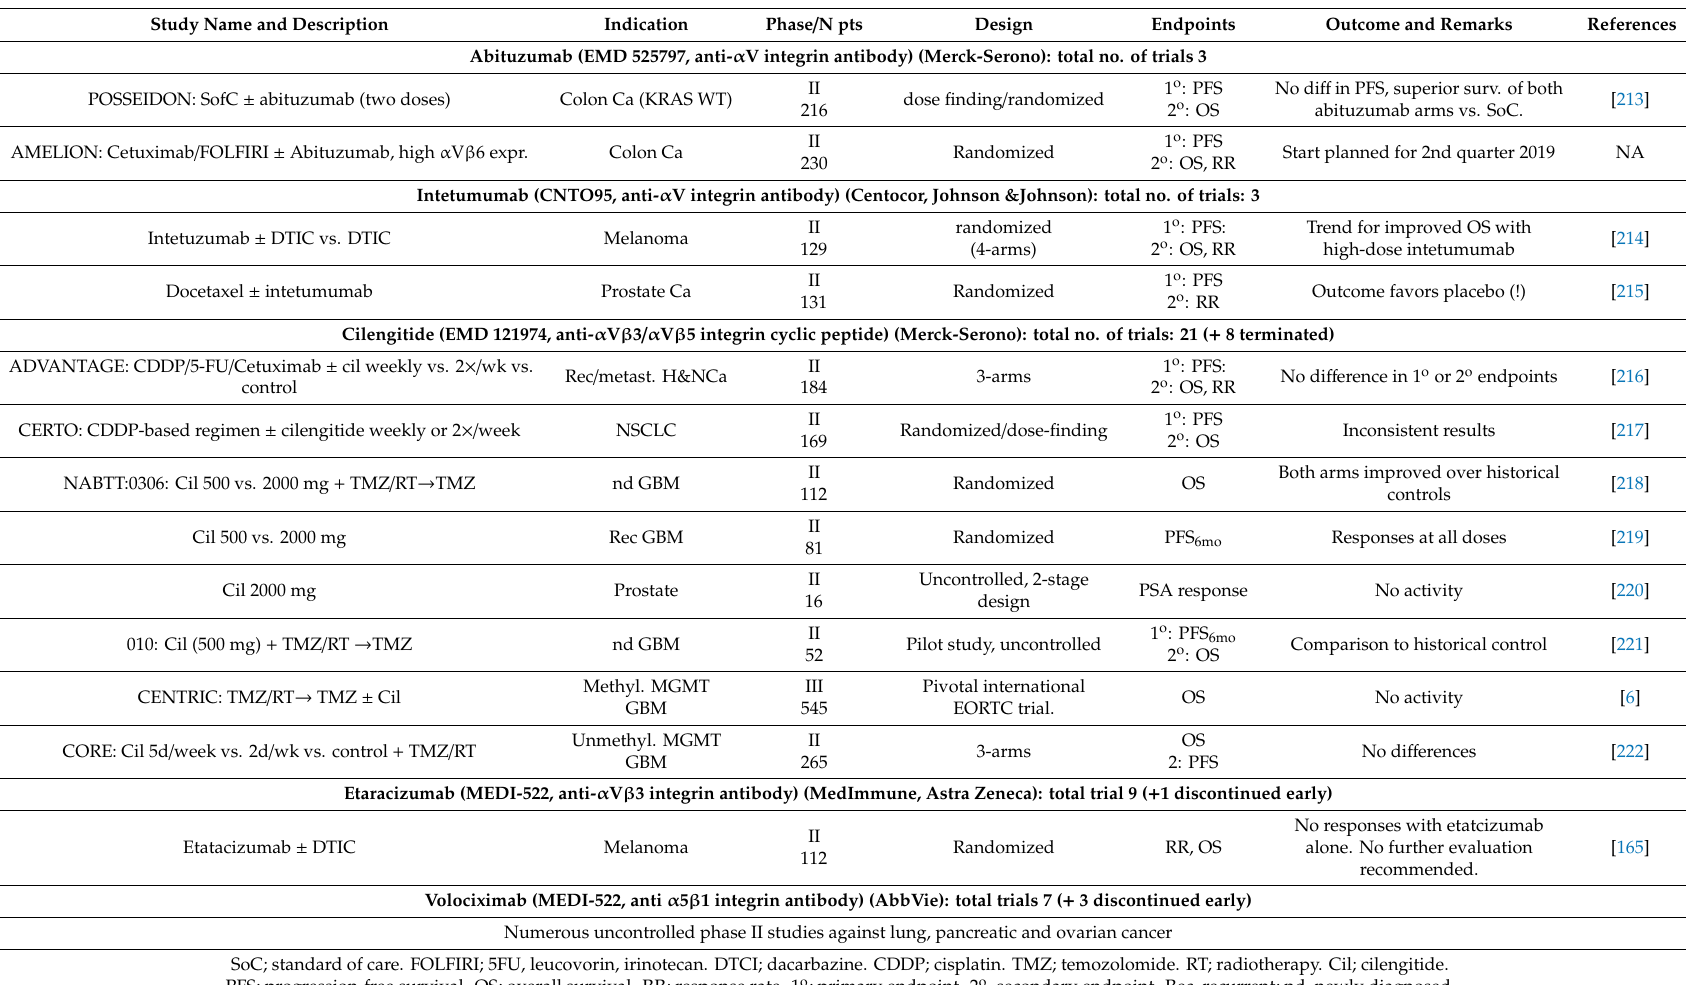
Table 2. Selected clinical trials of agents targeting integrins. Non-exhaustive listing of the recent most important clinical studies with integrin inhibitors and their salient features and